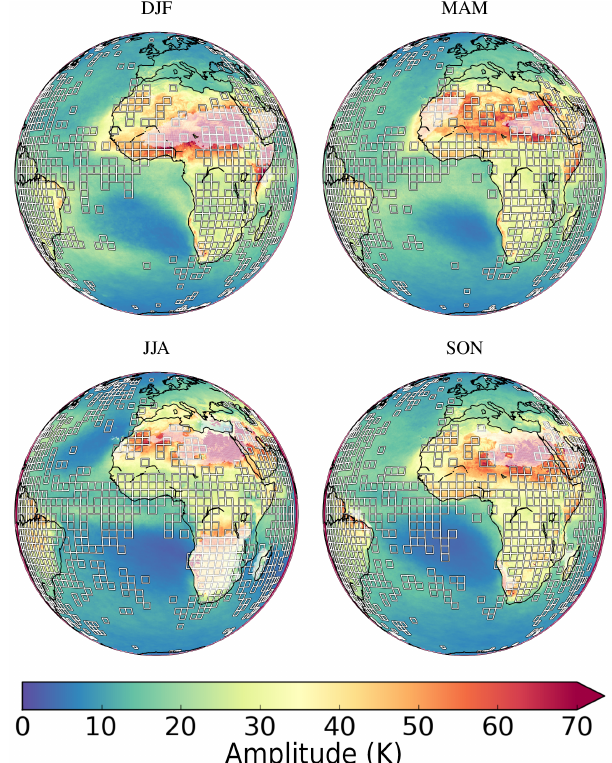
Figure 8. Seasonal mean amplitude of the diurnal cycle in SEVIRI cloud top temperature for the period 2005–2015. The white over- lay indicates regions where retrievals are available for fewer than 15% of the processed time steps. Squares indicate regions where the ratio of the amplitude of the diurnal cycle in CTT to the diurnal variability in CTT retrieval bias is less than